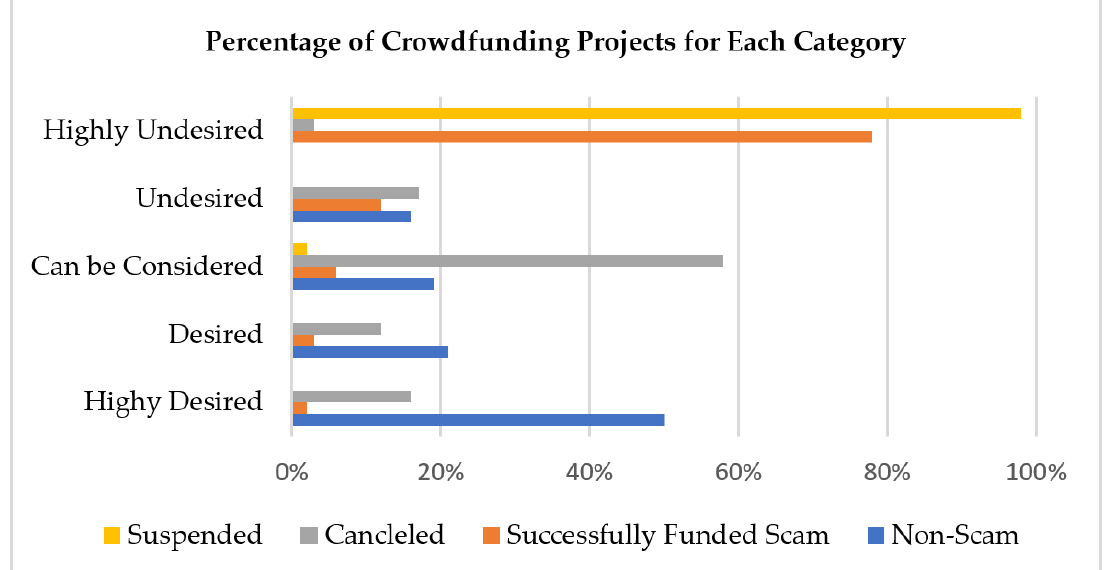
Figure 4. Percentage of crowdfunding projects for each category.